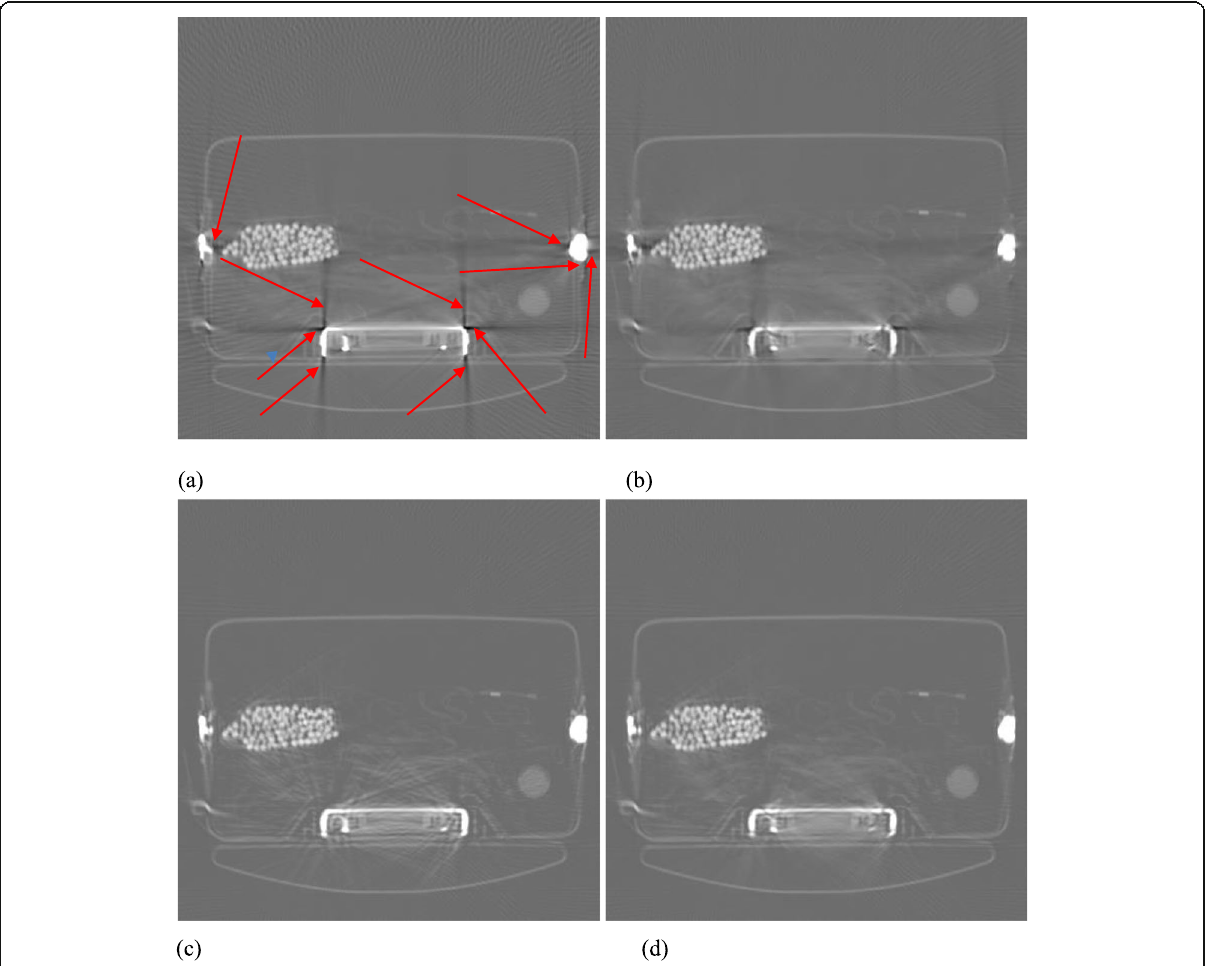
Fig. 2 Reconstruction of bag #2. a Raw FBP; b TV-term only; c Non-negativity-term only; d Combined. Some artifacts are marked by the red